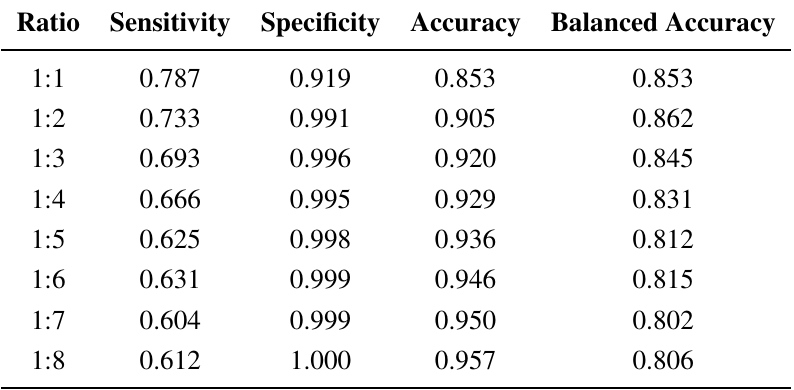
Table 2. The performance with different ratios between positive and negative samples in the training set without random sampling. The ratios of the number of positive samples to negative ones are from 1:1 to 1:8,